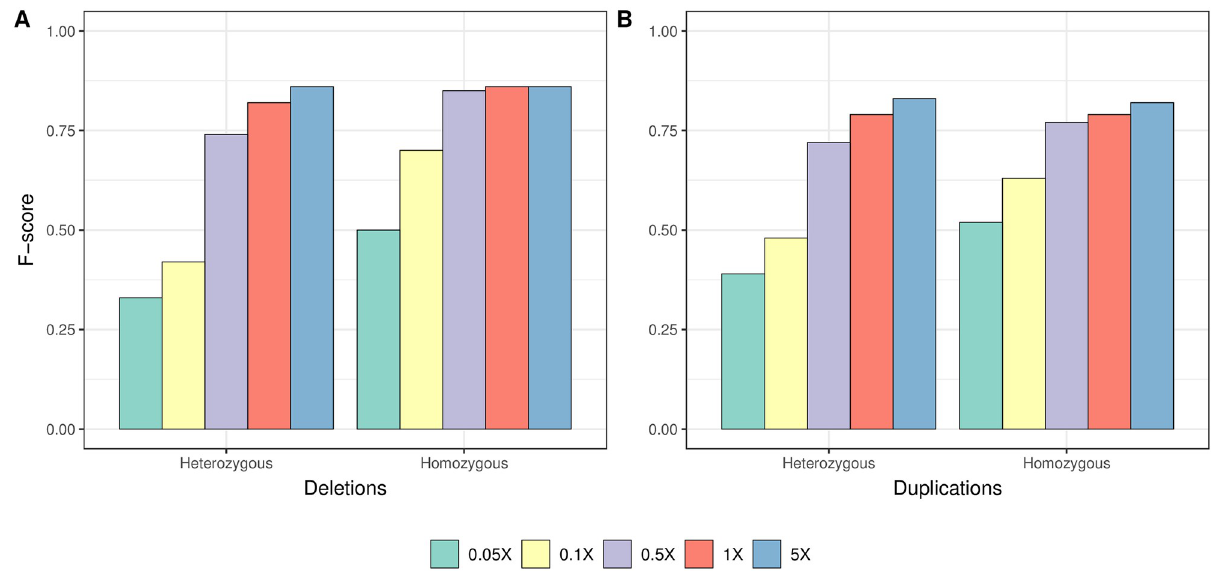
Fig 3. Performance of CONGA in correctly inferring copy-numbers. The figure shows the genotype (heterozygous vs homozygous) prediction performance CONGA for (A) deletions and (B) duplications using merged sets of medium and large CNVs, at various coverage